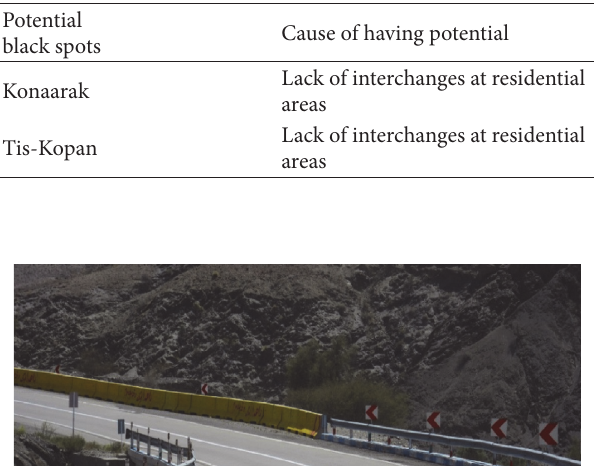
Table 8: Section 8: Konaarak-Chabahar.